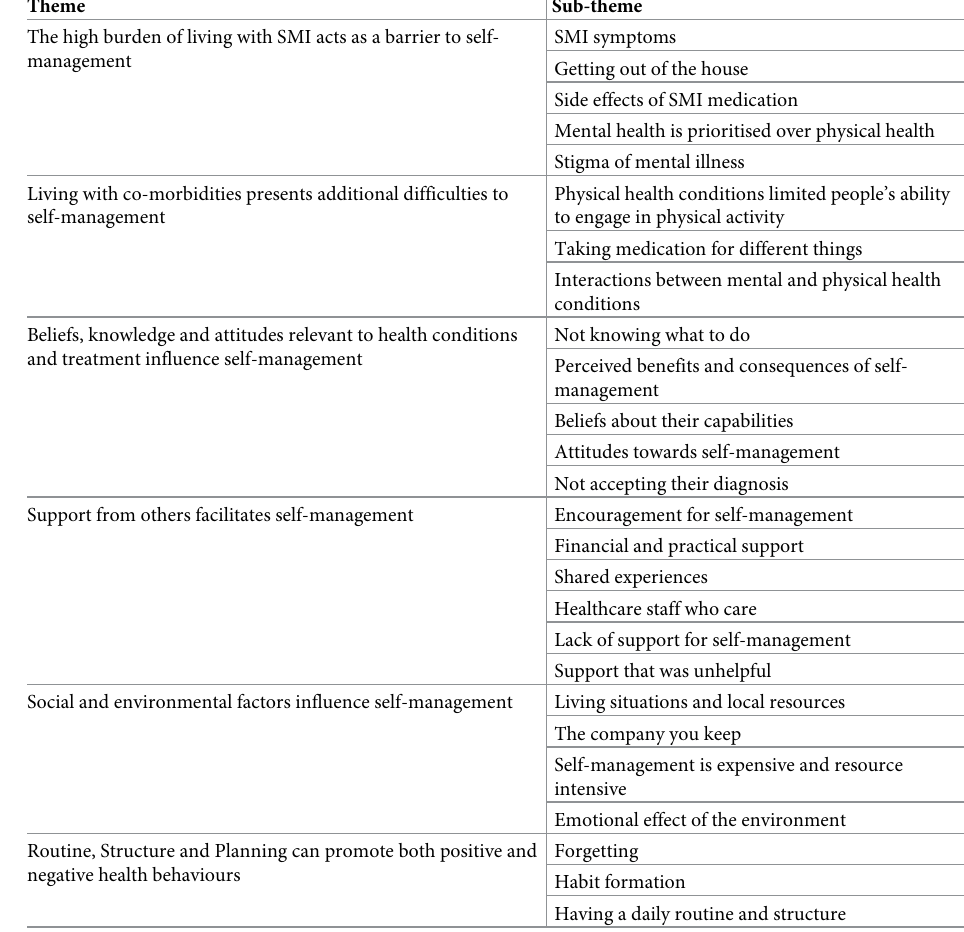
Table 3. Overview of themes and